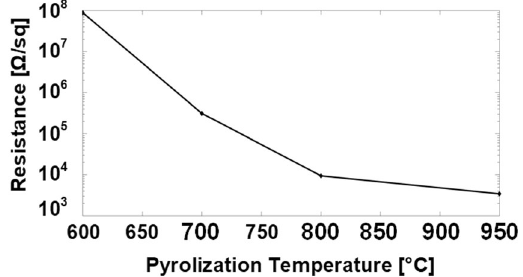
Fig. 5 Plot showing the variation of sheet resistance of the nano fi ber bundles with increasing pyrolyzation